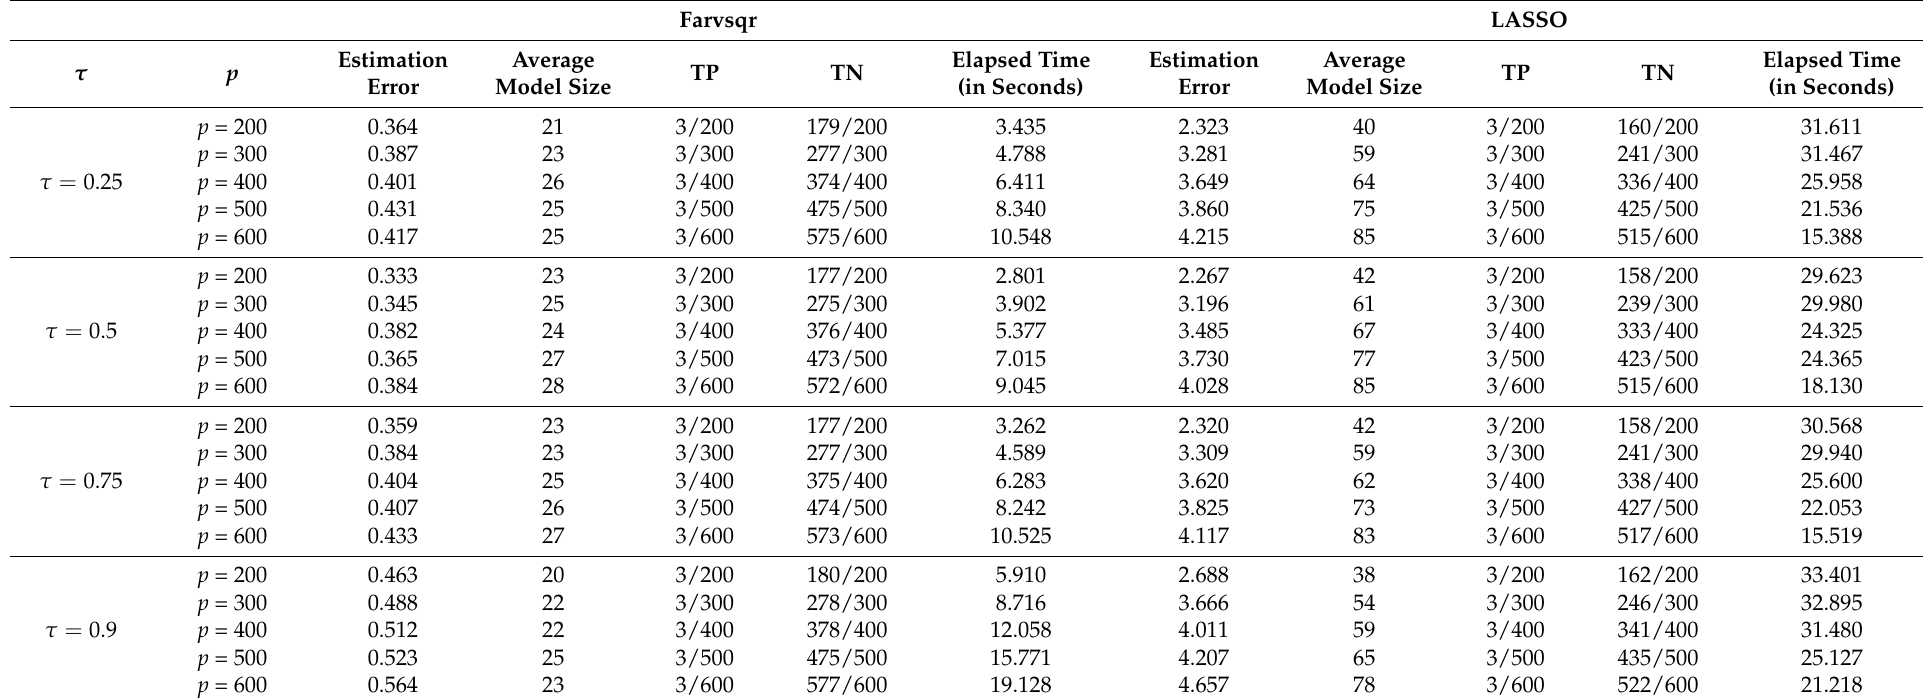
Table 6. The comparison for n = 1000,0.1 ∗ N ( 0,1 ) + 0.9 ∗ N ( 0,9 ) with the factor model. Farvsqr